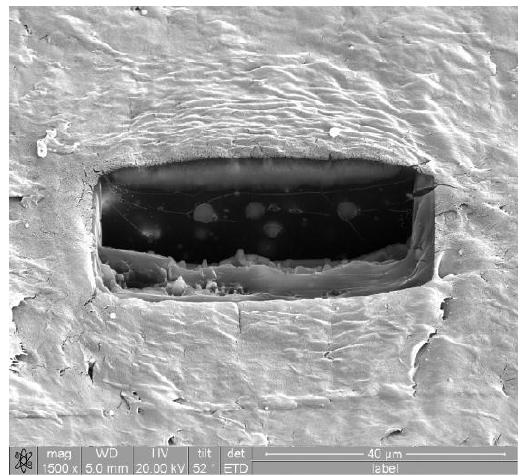
Figure 1. Scanning electron microscopy (SEM) micrograph of a polyethylene (LDPE) + Al composite after milling; the bar in the Figure is 40 µm.